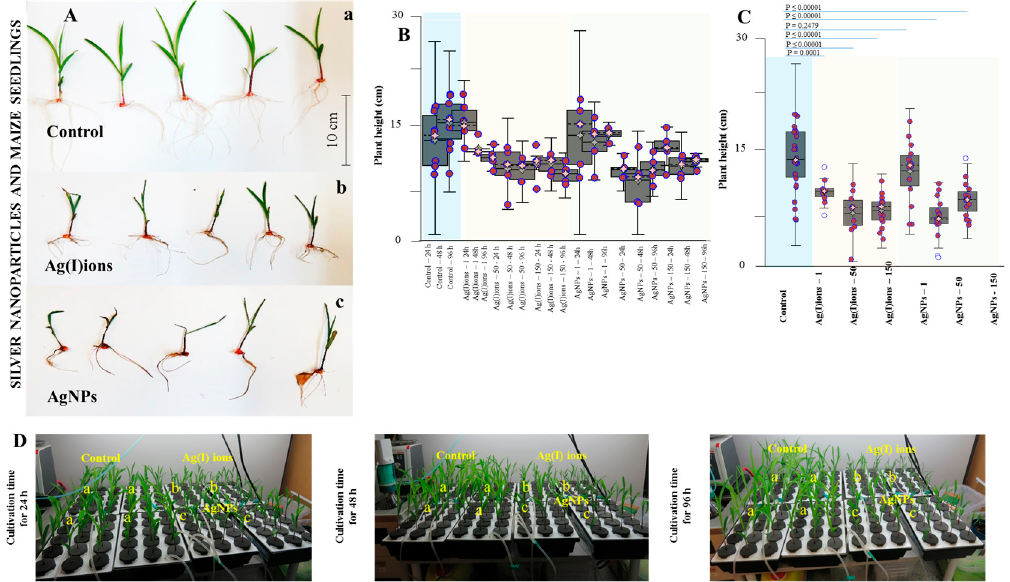
Figure 7. A basic study of the phytotoxic effect of AgNPs on plants of Zea mays in hydroponics. ( A )